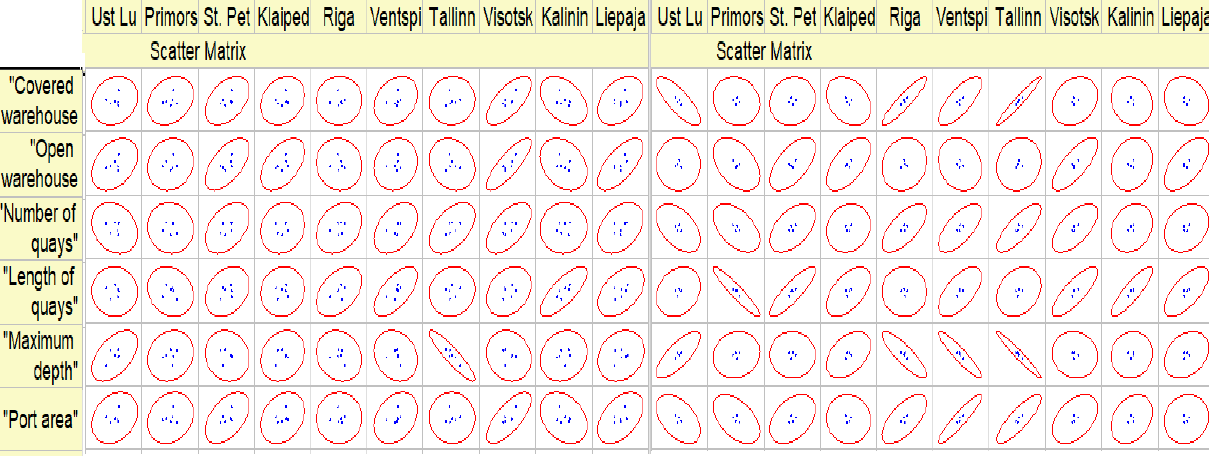
Figure 25. Correlation between cargo flows and the selected port infrastructure parameters (aggregate indicators are presented on the left and indicators before the COVID-19 pandemic—On the right).